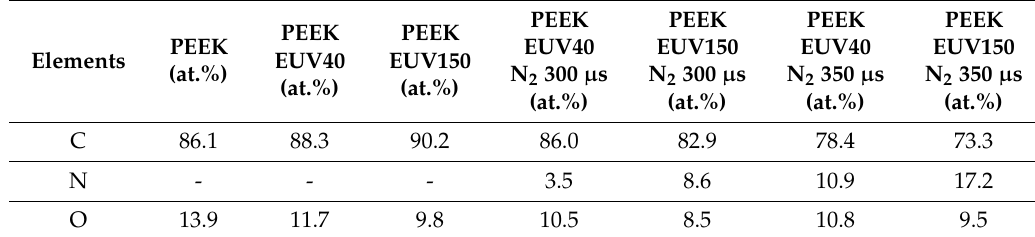
Table 2. The atomic concentration of carbon, nitrogen, and oxygen for unmodified and modified